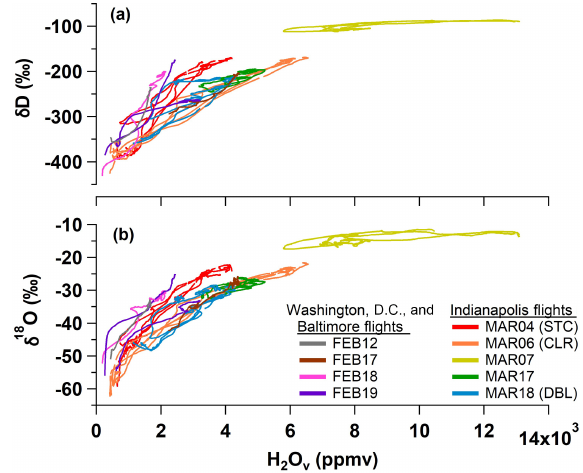
Figure 3. Measurements of (a) δ D and (b) δ 18 O versus H 2 O v mole fraction made during vertical profile (VP) descents on the nine re- search flights (Table 1).